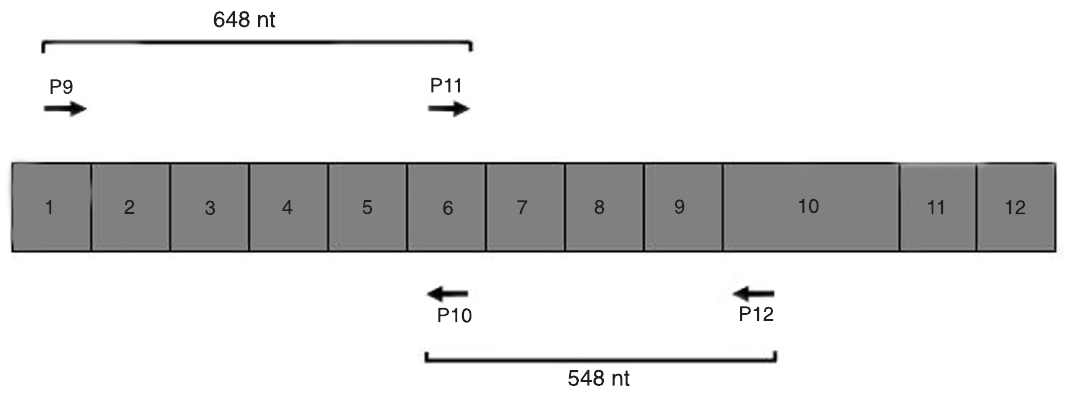
Figure 4. Primer pairs (P9-P10 and P11-P12) designed for AhR cDNA polymorphism studies. The spanned fragment size (nucleotides, nt) is indicated. Ahr = aryl hydrocarbon